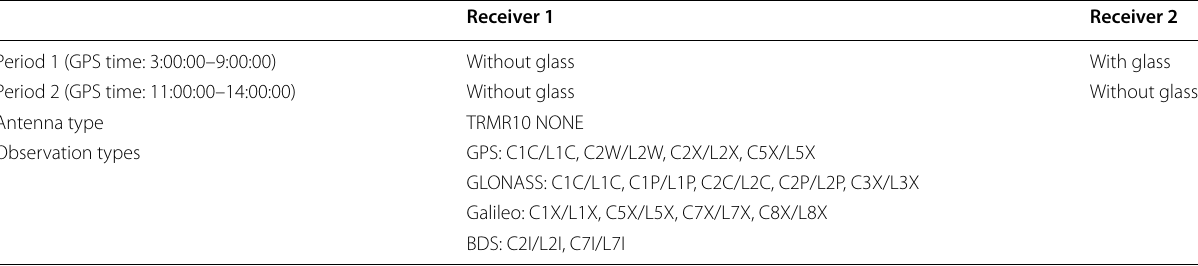
Table 1 GNSS observation types and the details of the two